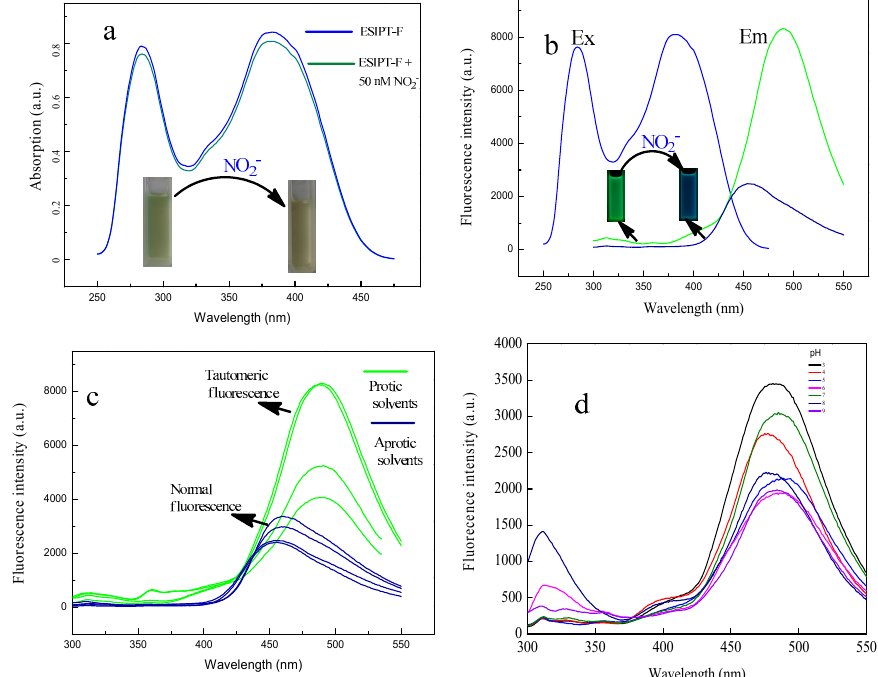
Figure 2. ( a ) Absorption and ( b ) fluorescence spectra of the probe ESIPT-F for NO 2 − (10 µ M); ( c ) Fluorescence spectra of ESIPT-F in aprotic and protic solvents, respectively ( λ ex : 285 nm); ( d ) Fluorescence spectra of ESIPT-F in DMF-HEPES buffer with different pH value (DMF: HEPES = 8:2; ESIPT-F = 5 µ M; λ ex = 285 nm; pH: 3~9).